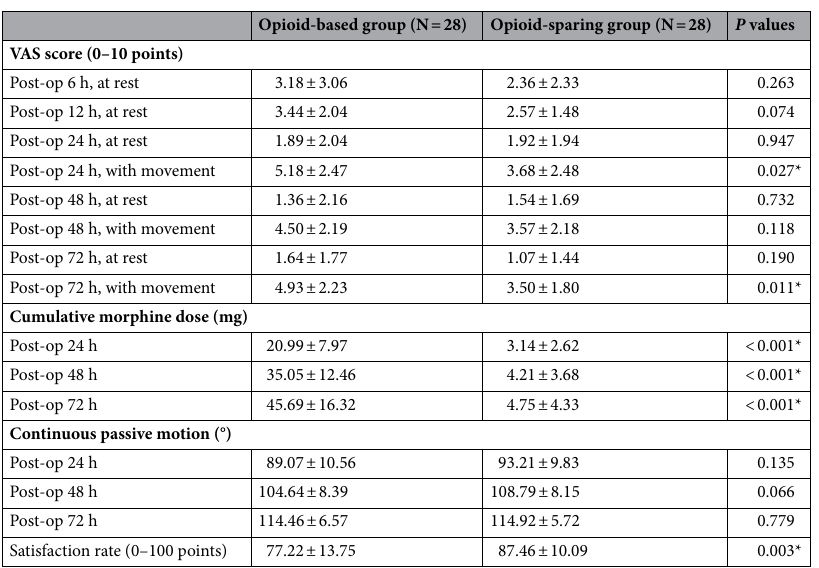
Table 2. Comparison of clinical outcomes after simultaneous bilateral TKA in both groups. * p <